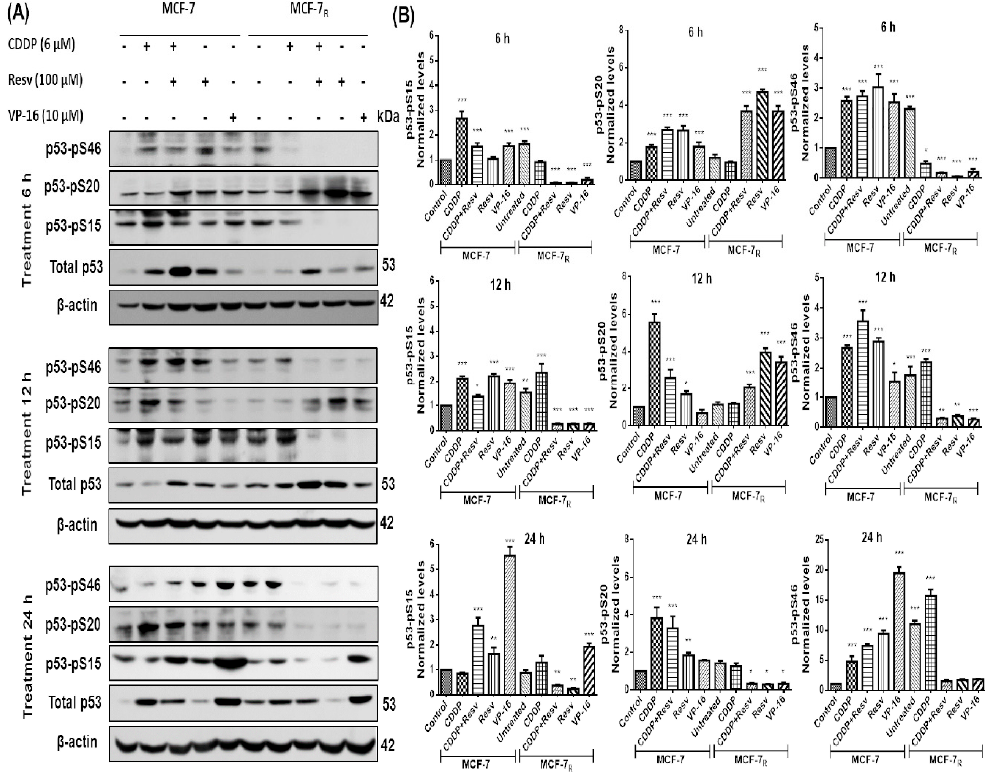
Figure 3. Resv induces serine 20 (S20) phosphorylation and attenuates phosphorylation of p53 in serine 15 (S15) and serine 46 (S46) in CDDP-treated MCF-7 R cells. ( A ) MCF-7 and MCF-7 R cells were treated with DMSO-ethanol vehicle as control or CDDP (6 μ M) with or without Resv (100 μ M) for 6, 12, and 24 h. Total and phospho-p53 contents were assessed by Western blot using antibodies directed against total p53 (DO-1) or against specific phosphorylated residues on p53, as indicated. VP-16 (10 μ M) treated cells was used as positive control of p53 phosphorylation. ( B ) Densitometric analysis of phospho-p53 after β -actin normalization. One-way ANOVA followed by Dunnett’s Multiple Comparison test were used to compare untreated MCF-7 cells (used as control group) with all the other groups of data at each time point. Results are presented as mean of three independent experiments ± SD. * p < 0.05; ** p < 0.01; *** p < 0.001.